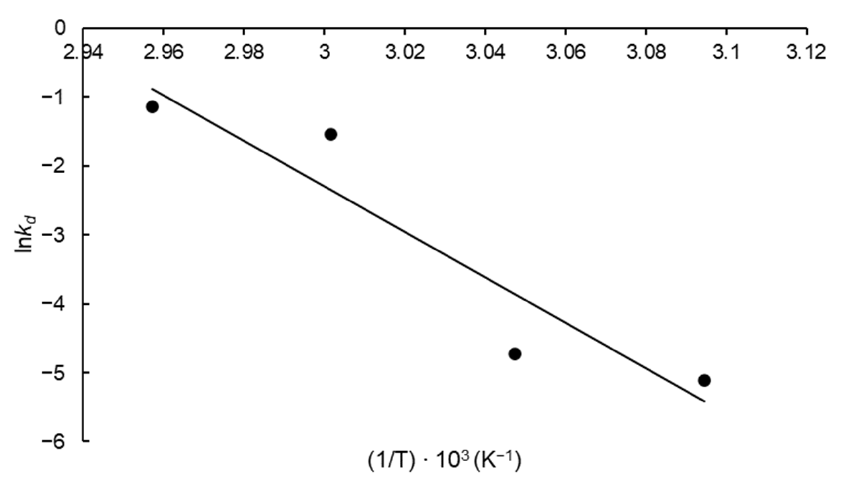
Figure 5. Arrhenius-type plot to estimate the thermal inactivation thermodynamic parameters of Figure 5. Arrhenius ‐ type plot to estimate the thermal inactivation thermodynamic parameters of FFase from A. tamarii Kita UCP 1279 produced by solid-state fermentation using a mixture of wheat FFase from A. tamarii Kita UCP 1279 produced by solid ‐ state fermentation using a mixture of wheat and soy bran as substrate ( R 2 = and soy bran as substrate ( R 2 = 0.88).